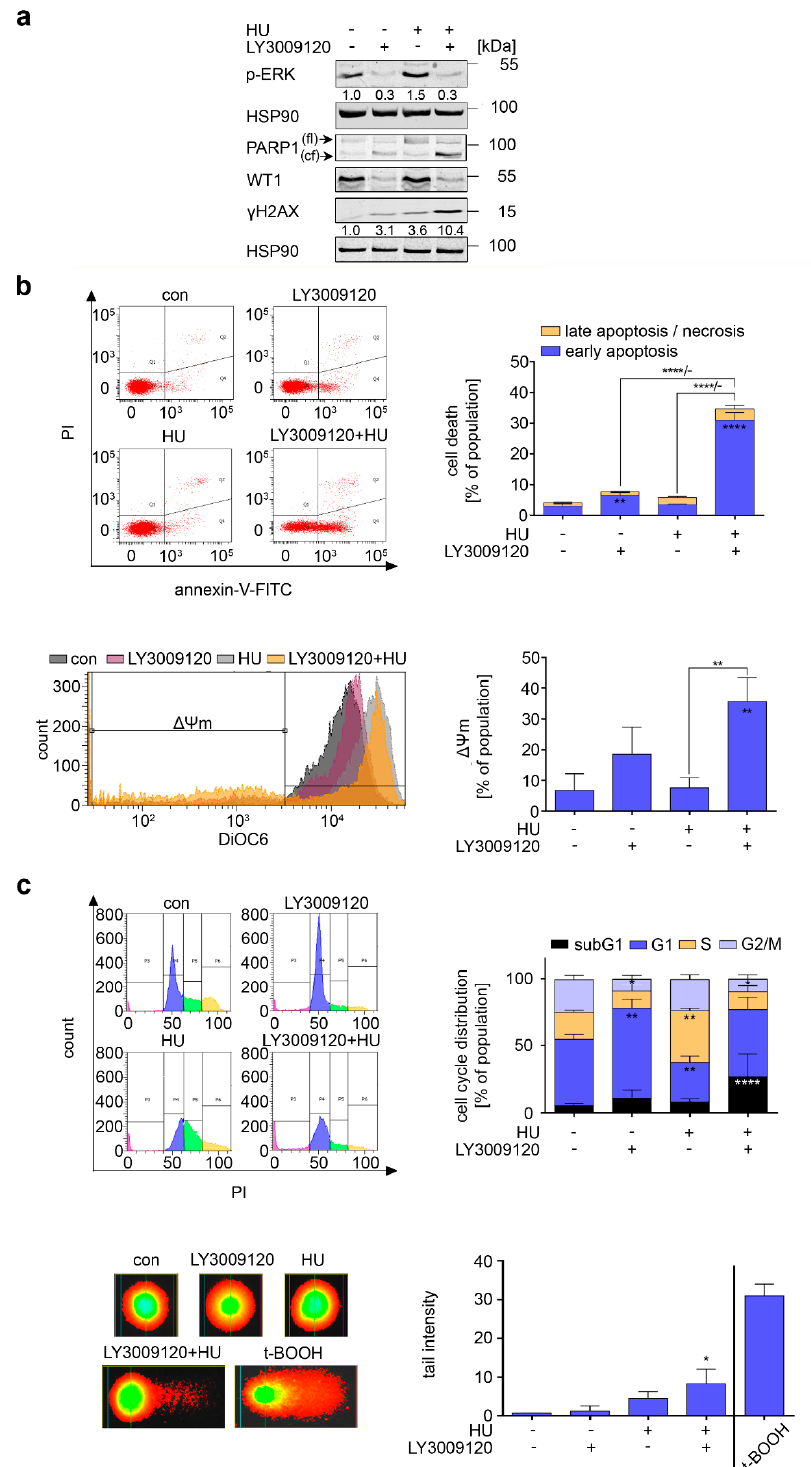
Figure 2. Inhibition of RAF and replication stress induce apoptosis in CML cells. ( a ) Immunoblot of K562 cells treated with 1 µM LY3009120 and 1 mM hydroxyurea (HU) for 24 h show the loss of p-ERK, WT1, and PARP1 and the induction of γ H2AX; (fl)—full length, (cf)—cleaved form; HSP90 serves as loading control. Numbers below p-ERK and γ H2AX show densiometric analyzes of the protein expression normalized to the loading control; protein levels of untreated cells were defined as 1.0. ( b ) Upper left: Exemplary dot plots of K562 cells exposed to 1 µ M LY3009120 and 1 mM HU